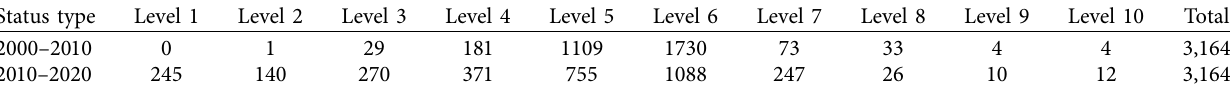
Figure 7: ESV change of Beijing (2000–2020). Table 3: Category conversion and unit quantity of EEH in the second green isolation area.